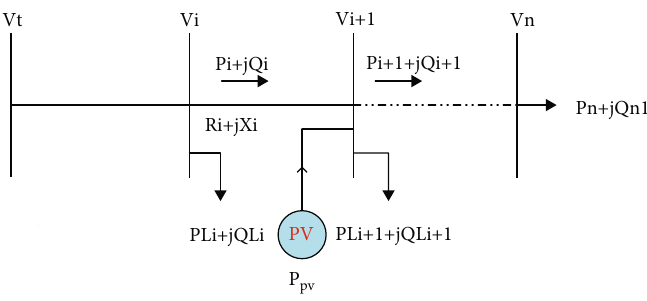
Figure 7: Distribution tie PV system.